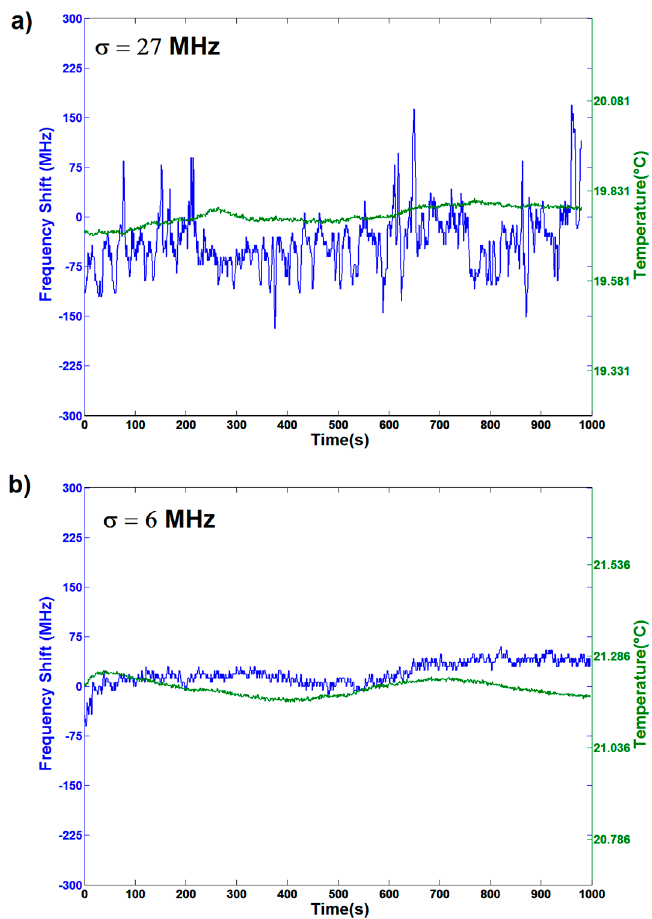
Figure 2. Resonance frequency (blue curves) and temperature fluctuations (green curves) versus elapsed time for an open space coupling in the case of air- ( a ) and water- ( b ) filling of the resonator. The correspondent value of σ is 27 MHz in the former case ( a ), and it reduces to 6 MHz in the latter ( b ). In the case of water-filling, a direct correlation of resonance frequency and temperature oscillation is clearly observable.